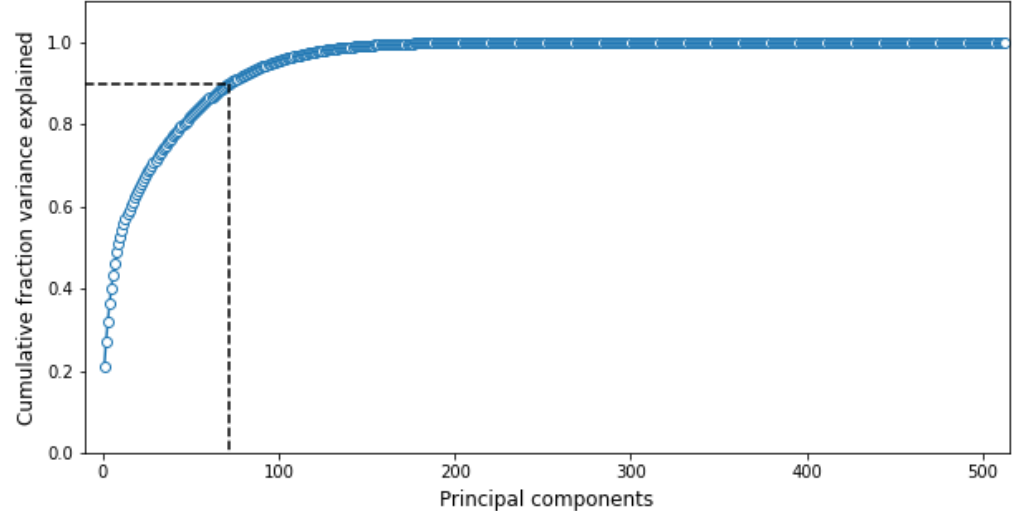
Figure 10. Cumulative fraction variance explained by each principal component from CNN feature extraction with transfer learning, for a window length of 150 time steps.